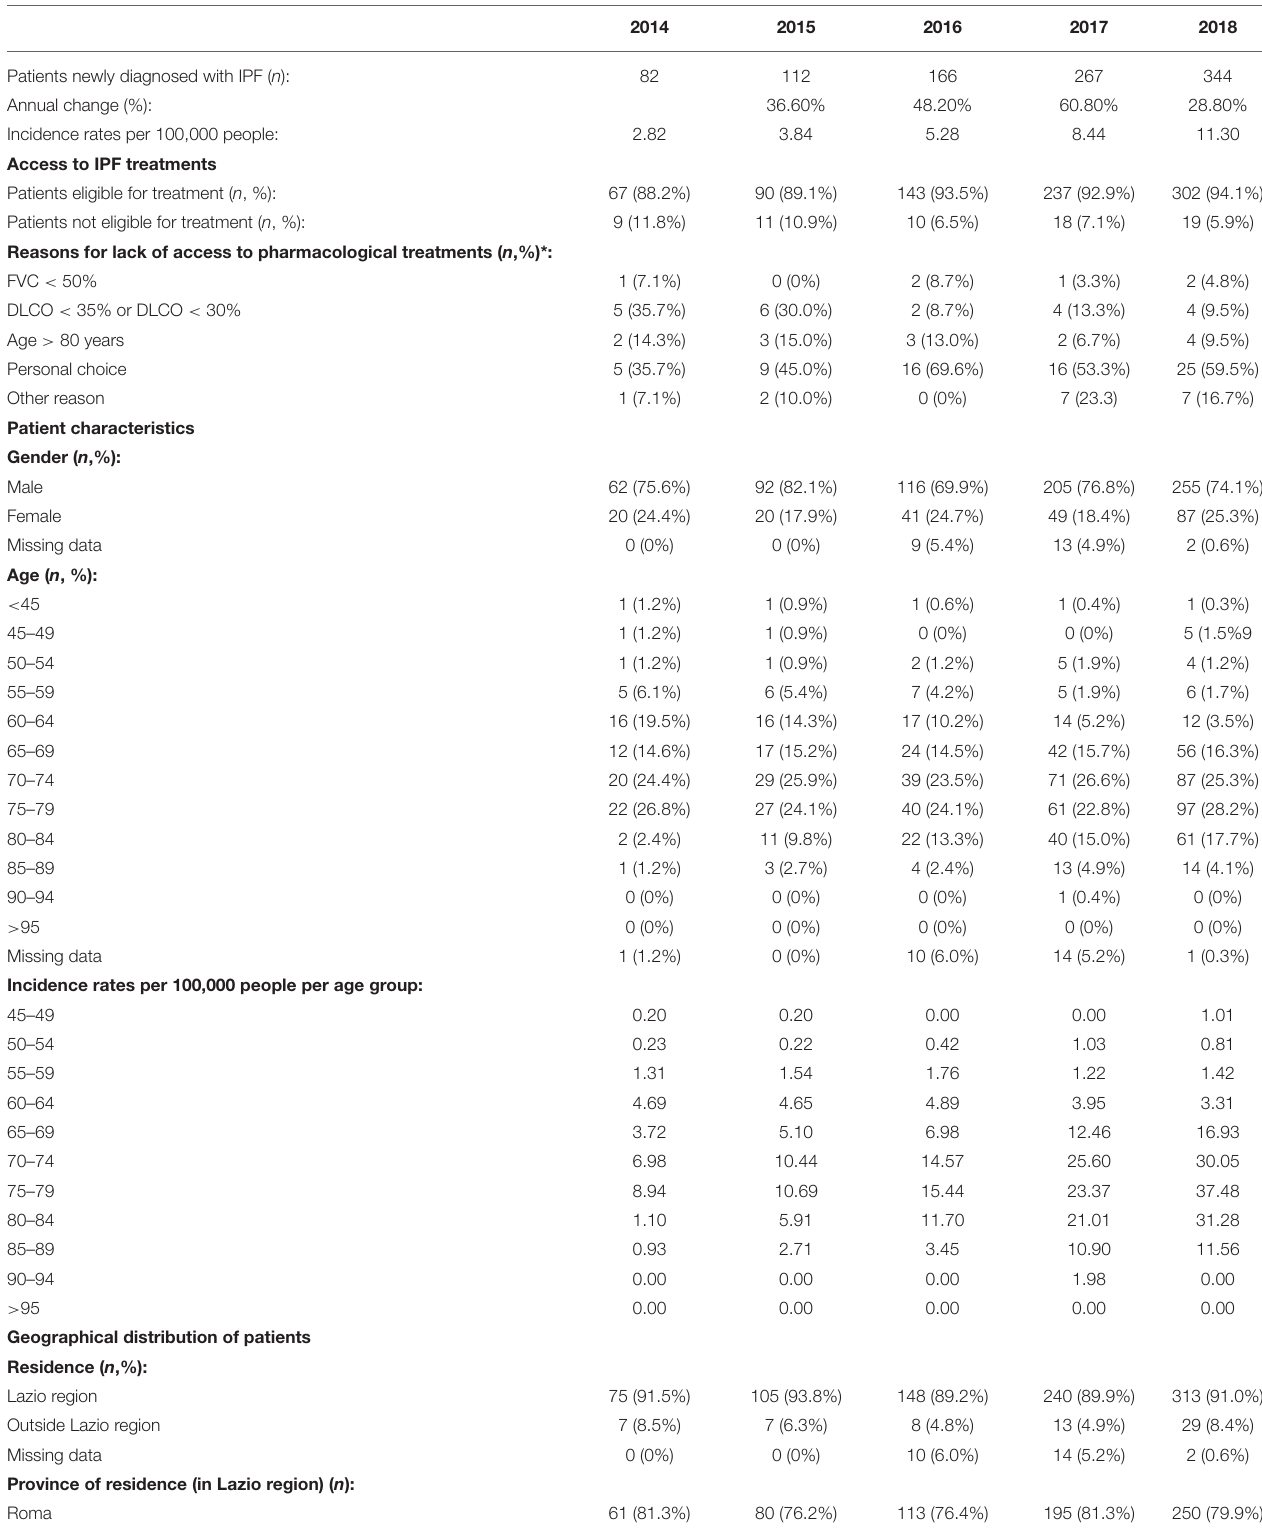
TABLE 1 | Patients with confirmed diagnosis of IPF in the Lazio region from 2014 to